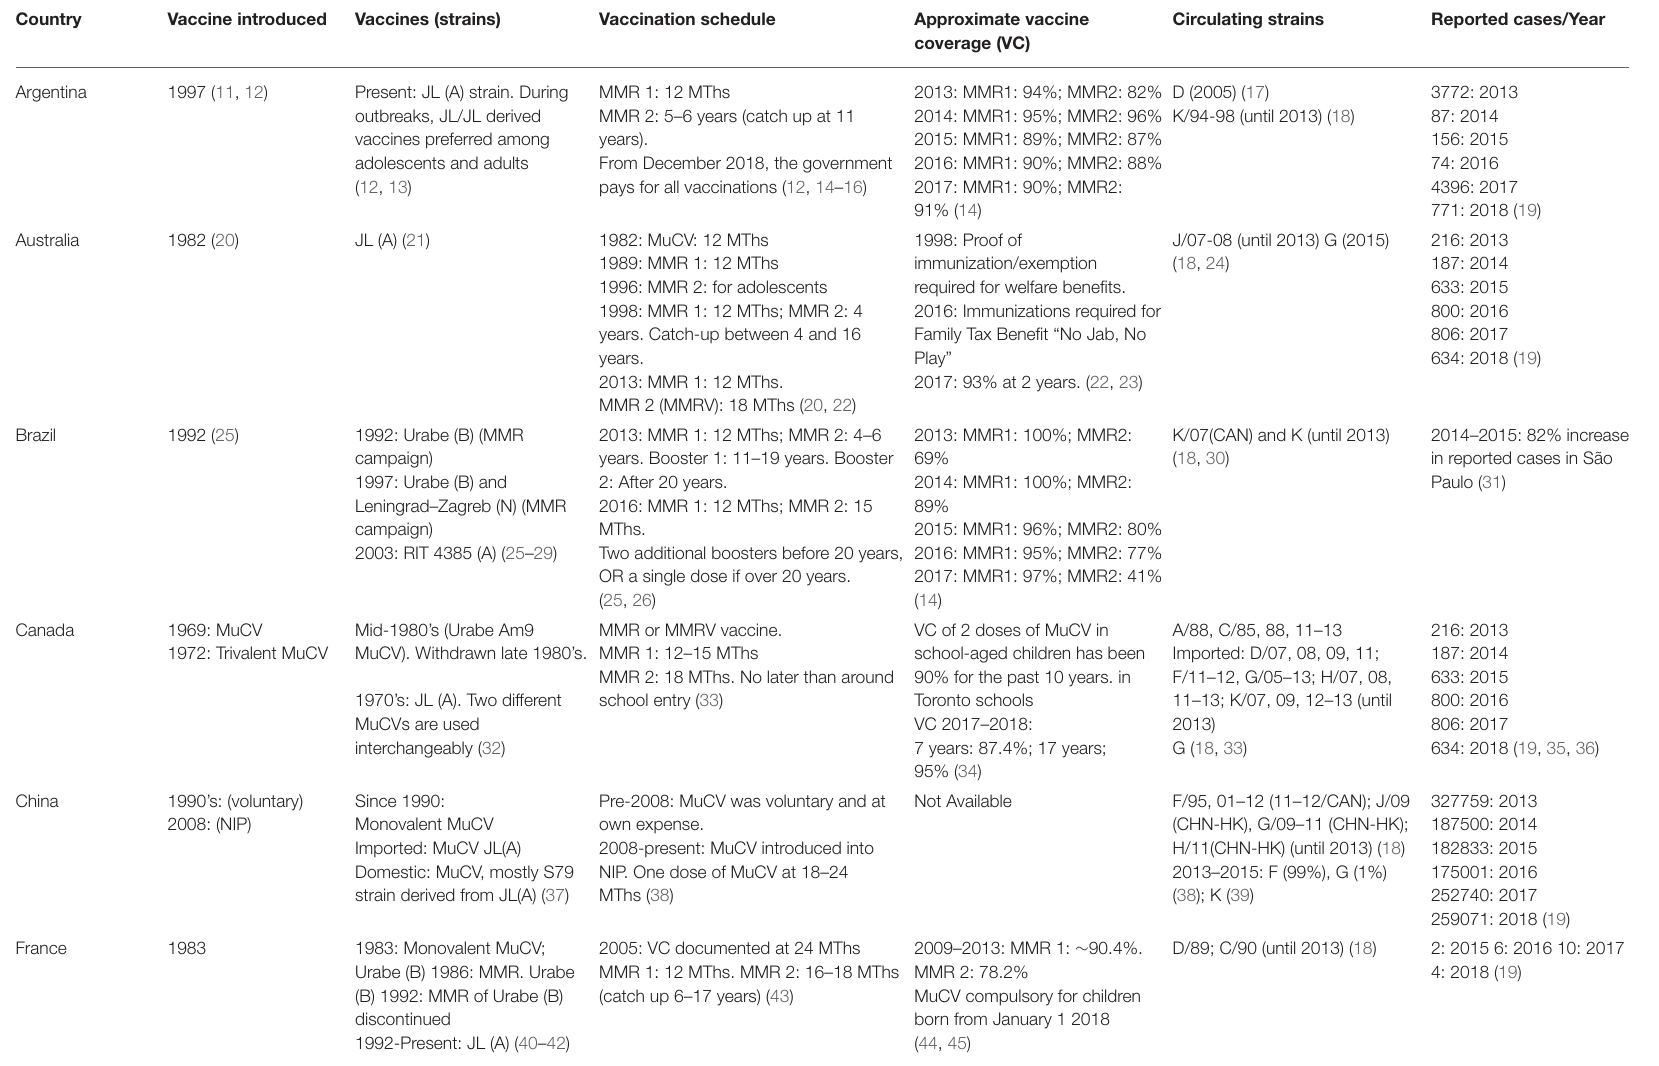
TABLE 1 | Comparison of vaccine strain, schedule, and coverage in contrast to the circulating mumps strain and reported cases/year within G20 countries who currently utilize mumps containing vaccines as part of the national vaccination schedule.